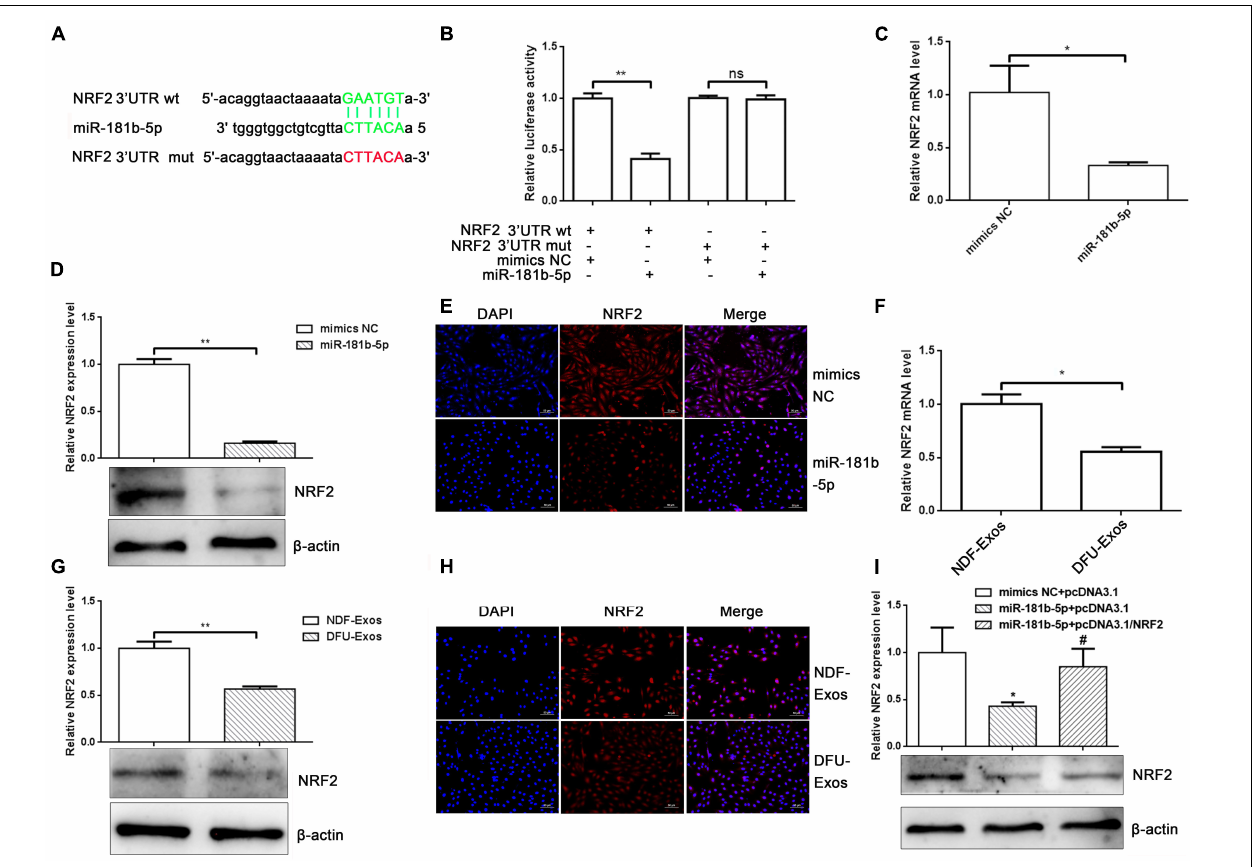
FIGURE 3 | miR-181b-5p regulated NRF2 expression by targeting its 3 (cid:48) UTR. (A) Binding of miR-181b-5p and NRF2 3 (cid:48) UTR. (B) Dual luciferase assay showing luciferase activity alteration upon co-transfecting pmiR-GLO-NRF2 3 (cid:48) UTR wild-type or mutated and overexpressing or inhibiting miR-181b-5p. ** P < 0.01 vs. mimics NC + NRF2 3 (cid:48) UTR wt. (C) qRT-PCR, (D) Western blotting, and (E) immunofluorescence stain showing the expression of NRF2 after overexpressing miR-181b-5p. * P < 0.05, ** P < 0.01 vs. mimics NC. (F) qRT-PCR results, (G) Western blotting, and (H) immunofluorescence stain showing the expression of NRF2 in HUVECs incubated with NDF-Exos and DFU-Exos. * P < 0.05, ** P < 0.01 vs. NDF-Exos. Western blotting (I) showed the expression of HO-1 in rescue experiments. * P < 0.05 vs. mimics NC + pcDNA3.1, # P < 0.05 vs. miR-181b-5p + pcDNA3.1.